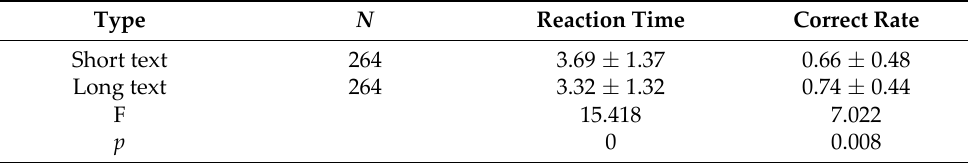
Table 5. Descriptive statistics showing length of response time and correct